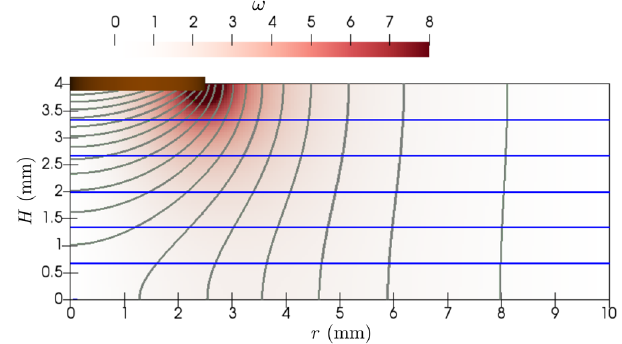
FIG. 5. Baroclinic vorticity generation rate ∂ ω = ∂ t ≈ ð 1 = ρ 2 Þð ∇ ρ × ∇ p Þ normal to a radial cross section before flow is initiated by a yeast colony fixed at the surface of the viscous fluid in a radially symmetric Petri dish. The colony position is indicated by the brown bar, the pressure isobars in blue, and the density contours in gray. The isobars are near horizontal due to small density differences originating from nutrient depletion (in ∼ − 0 . 003 g = mL). Whenever the pressure this simulation, Δ ρ max and density contours cross at an angle, vorticity is generated via the baroclinic term in Eq.